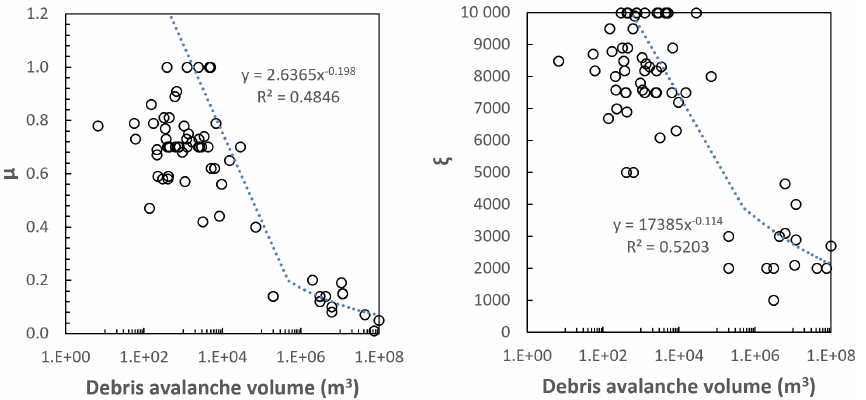
Figure C1. Debris avalanches: range of parameters used to back analyse the runout of debris avalanches published in the literature ( n = 67), using the RAMMS